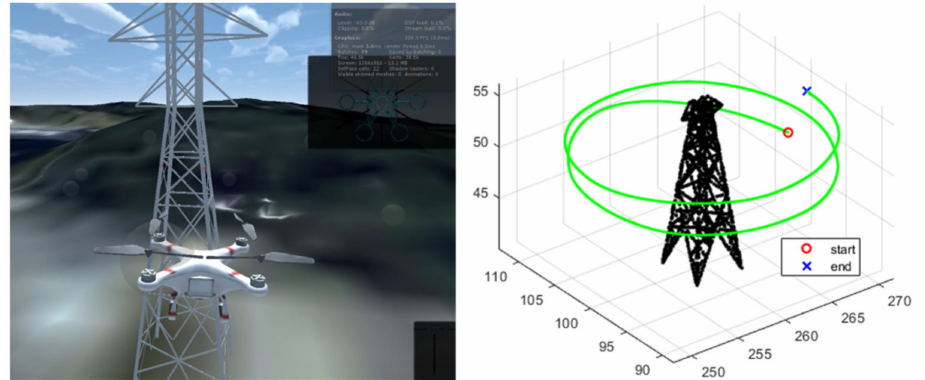
Figure 6. Unity-based simulator ( Left ) and flight path of simulation ( Right